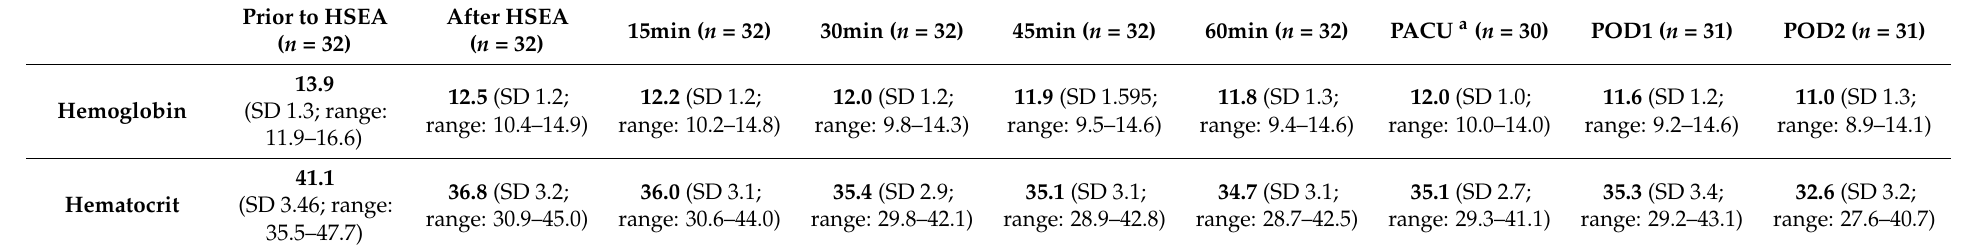
Table 1. Changes in hemoglobin (g/dL) and hematocrit after initiation of a hypotensive spinal-epidural anesthesia (HSEA). a Post Anesthesia Care Unit (PACU).